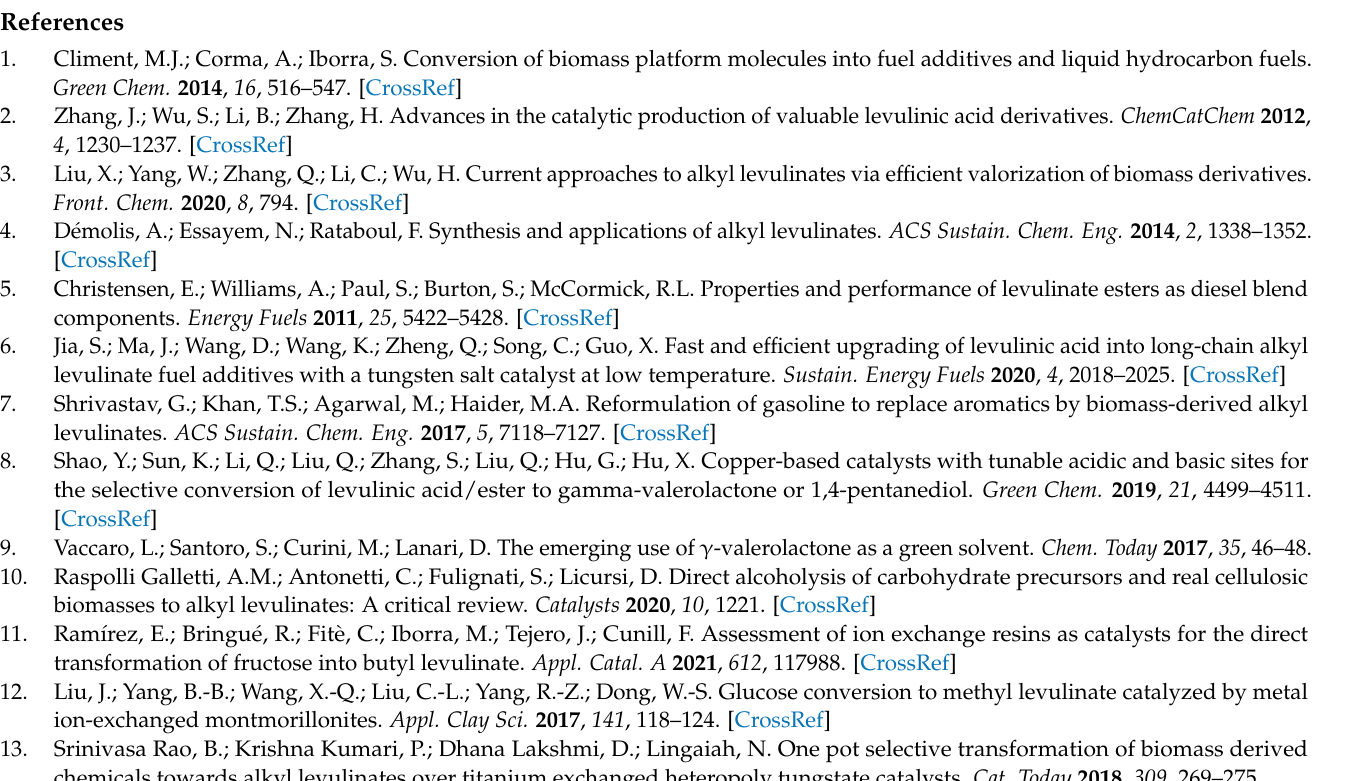
Table S2: Synthesis of EtLev starting from FA at different temperatures; Table S3: Synthesis of EtLev starting from FA employing different solvent amount; Table S4: Synthesis of EtLev starting from FA: Preliminary investigation for catalyst recycling; Scheme S1: Reaction scheme of EtLev